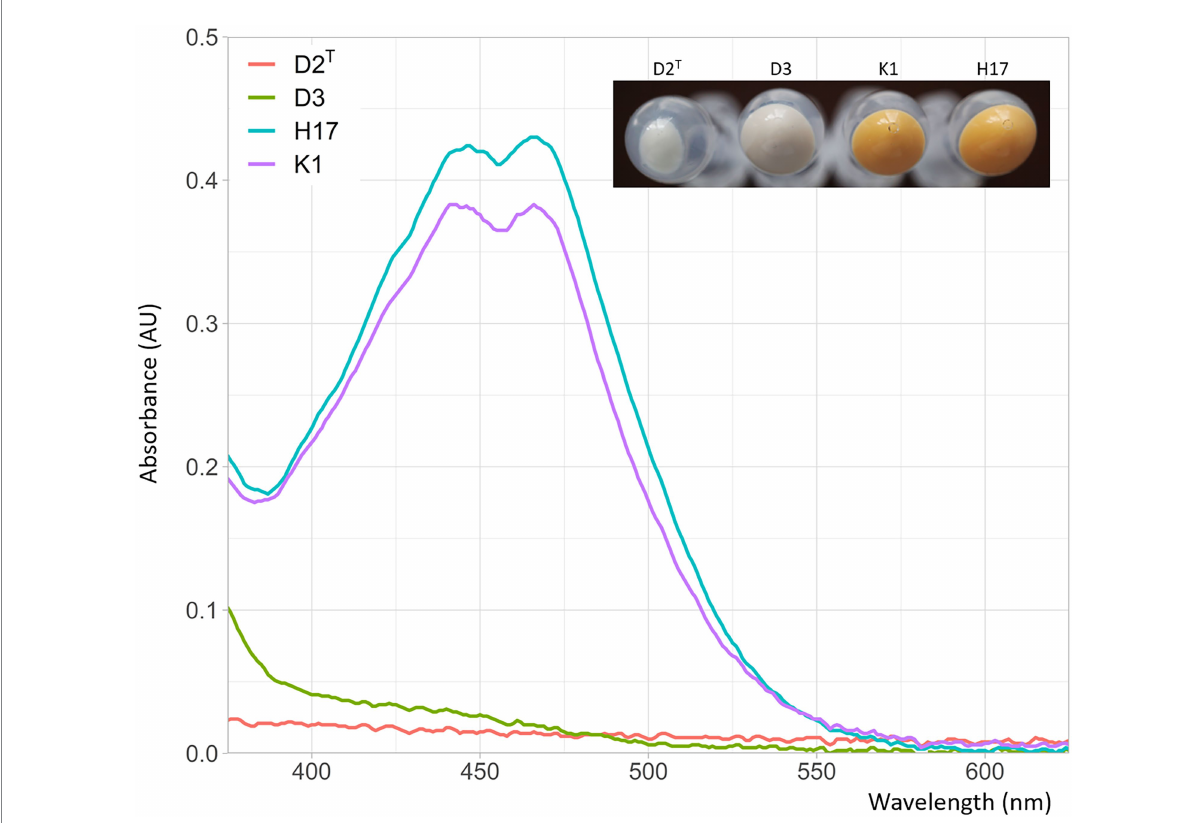
FIGURE 5 Absorbance of methanol extracts from Staphylococcus capitis isolates in absorbance units (AU) at wavelengths of 375–625 nm. Photographic image shows the collected biomass of two inoculated R2A agar plates used for methanol extraction with resulting cell counts of 2.3 x 10 10 CFU/mL